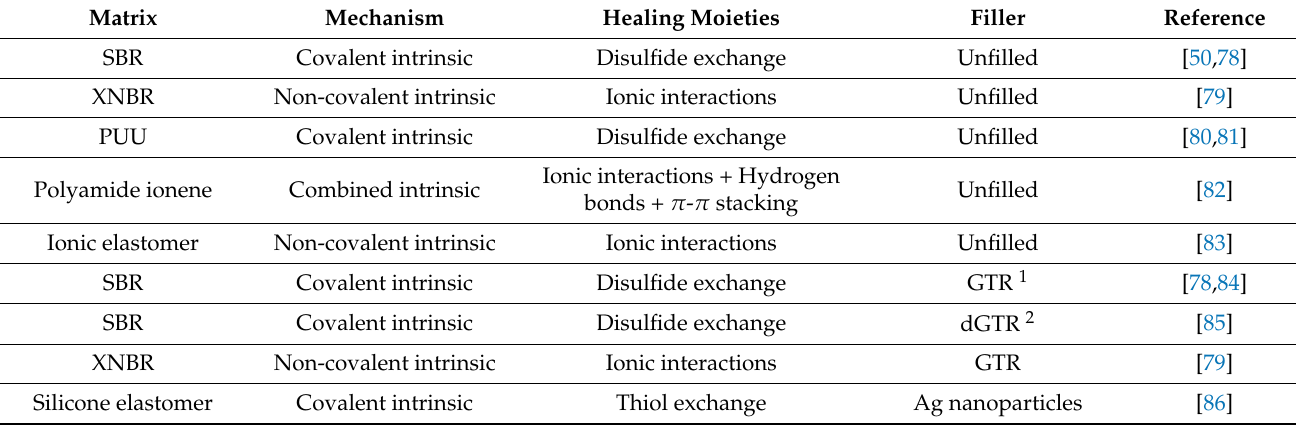
Table 2. Self-healing synthetic elastomers research conducted in Spain